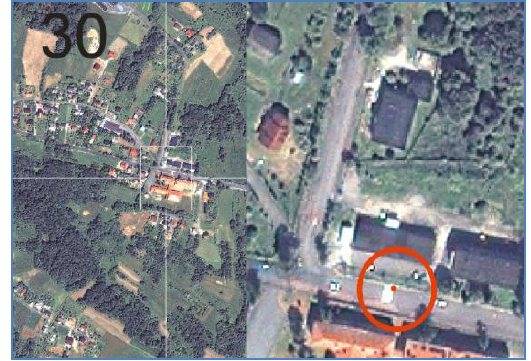
Fig. 3 Image location of one of control point